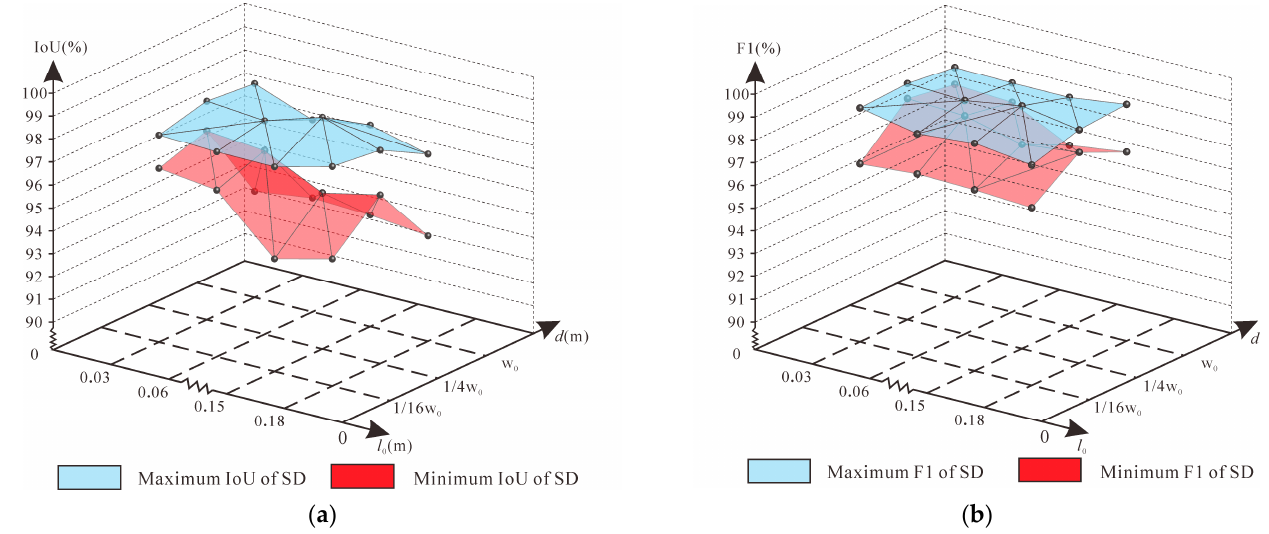
Figure 18. The extraction accuracy corresponds to each voxel. ( a ) The IoU corresponding to each voxel. ( b ) The F1 corresponding to each voxel.